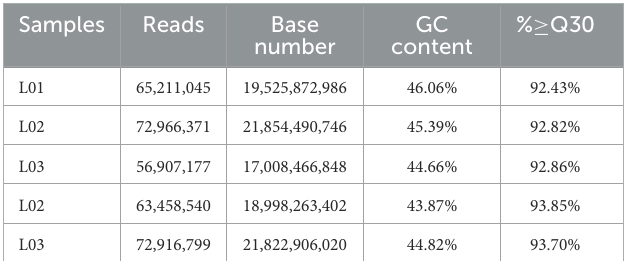
TABLE 3 Evaluation statistics of sample sequencing